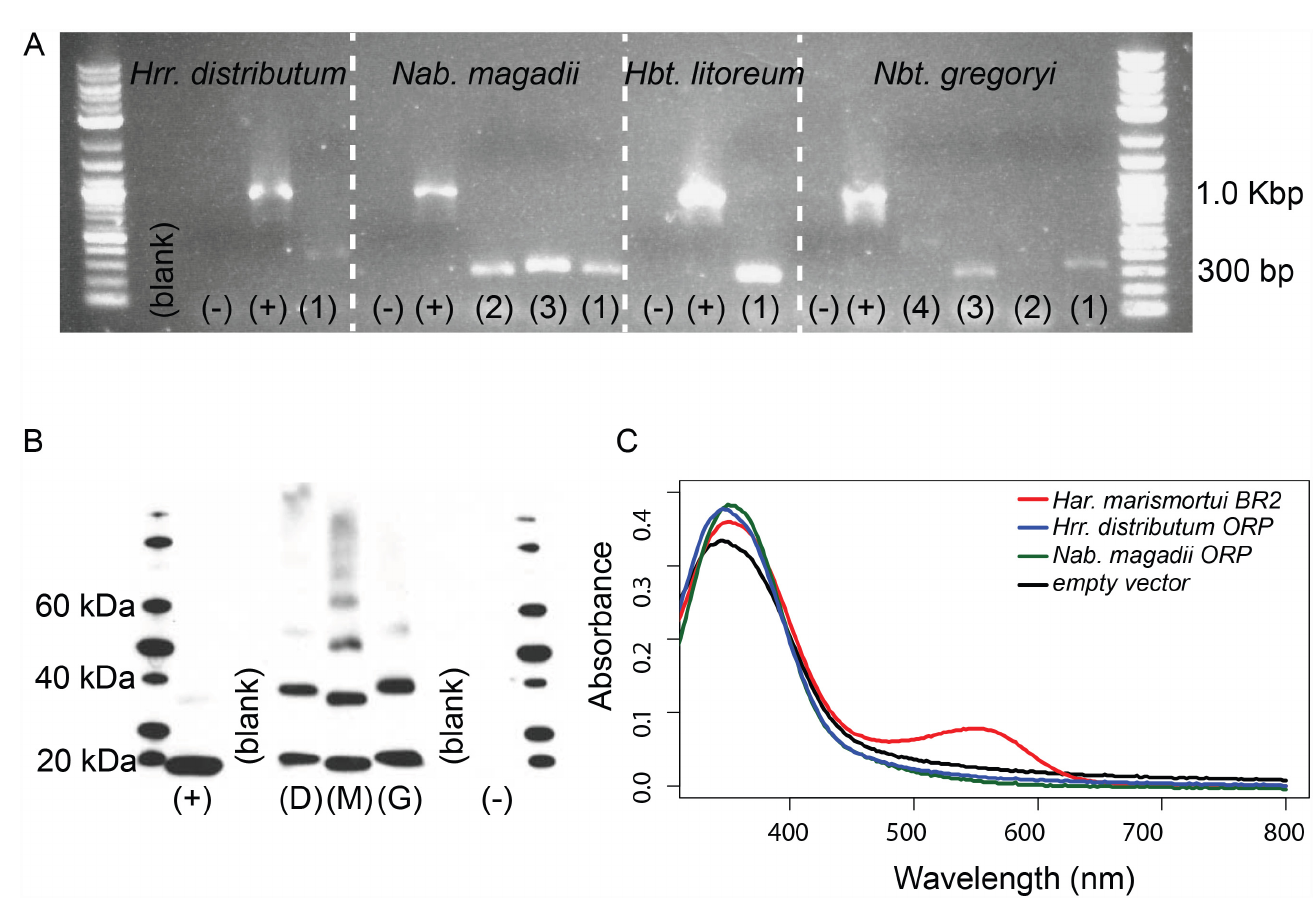
Fig 4. Heterologously expressed ORP homologs do not display retinal-dependent light absorption. A. Transcription of ORPs under standard laboratory conditions was confirmed in four native hosts from both ORP clades. Eight of nine tested ORPs were transcribed, many at low levels. Positive controls are 16S rRNA gene products. Halorubrum distributum JCM 9100 (1) = ELZ45759. Natrialba magadii DSM 3394 (1) = WP_004215682, (2) = WP_004267173, (3) = WP_004267171. Halorubrum . litoreum (1) = WP_008366300. Natronobacterium gregoryi (1) = WP_005581268, (2) = WP_005575895, (3) = WP_015233632, (4) = WP_005579638. B. Heterologous expression of ORP proteins was confirmed by Western blot. D = Halorubrum distributum JCM 9100 ELZ45759, M = Natrialba magadii DSM 3394 WP_004267173, G = Natronobacterium gregoryi DSM 3393 WP_005575895. Positive control = Haloarcula . marismortui BR2 YP_137573. C. Visible light spectra of heterologously expressed bacteriorhodopsin and opsin-related proteins cultivated and purified in the presence of excess retinal. The positive control Haloarcula marismortui BR2 = YP_137573 shows a canonical absorption peak while the two ORP homologs Halorubrum distributum ORP = ELZ45759. Natrialba magadii ORP = WP_004267173 shows no peak in the canonical region (480 – 580 nm) suggesting that retinal has not bound the apoprotein. Protein expression is verified by absorbance at 280 nm and by Western blot (panel